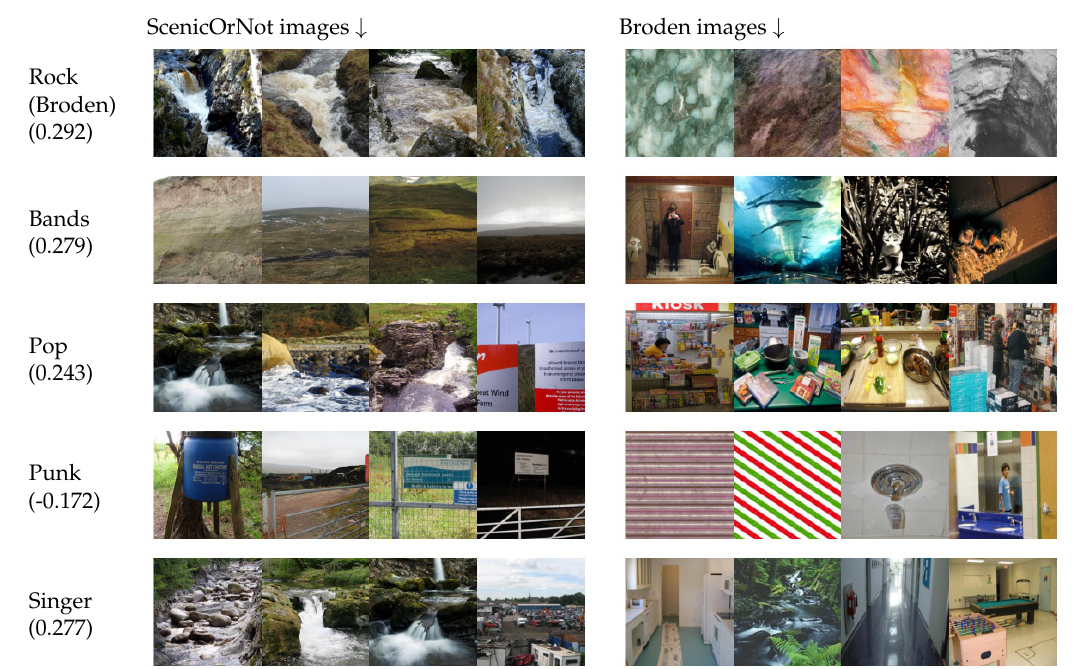
Figure 14. Closest images for rock, a concept that has been trained with visual examples from Broden (top row) and its corresponding neighboring concepts from GloVe. Each concept shows its correlation with scenicness in the latent space.